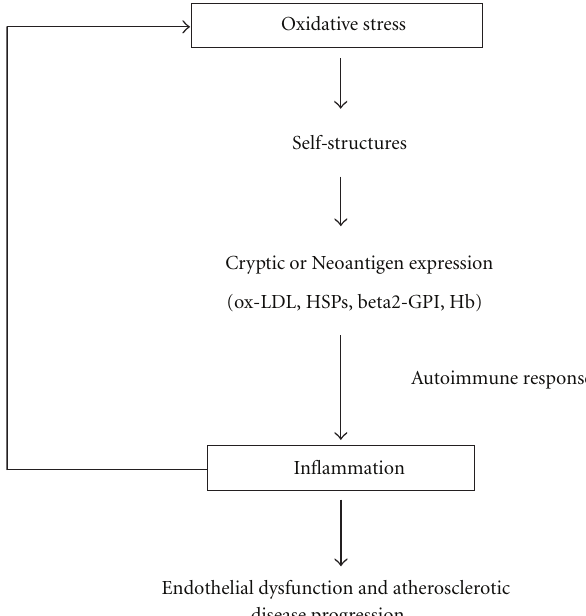
Figure 1: Schematic representation of the relationship between oxidative stress and inflammation in cardiovascular diseases. Patients with atherosclerosis are characterized by strong oxidative stress conditions. Prooxidant compounds that form may interact with molecular and cellular components thus determining expres- sion of cryptic antigens, such as HSPs, and/or structural modifica- tions of self-molecules and generation of neoepitopes, such as oxi- dized LDL. These cryptic or neoantigens may trigger autoimmune reactions, thus sustaining the inflammatory mechanisms involved in endothelial dysfunction and plaque progression. Of note, molec- ular and cellular mediators of inflammatory mechanisms sustain oxidative stress, thus creating a pathogenic system that amplifies itself. Ox-LDL: oxidized low-density lipoproteins; HSPs: heat shock proteins; beta2-GPI: beta2-glycoprotein I; Hb: